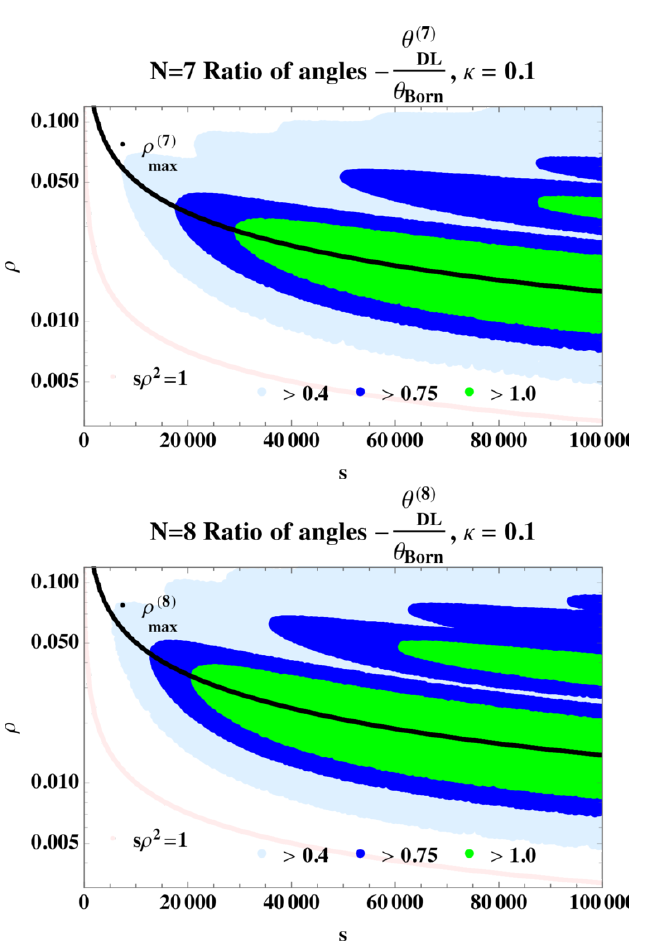
Figure 14 . Regions in impact parameter and energy space where the DL resummation e(cid:11)ects are large ( N =7 up, N =8 bottom). When the ratio (cid:0) (cid:18) it is bigger than 0.4 and 0.75, it corresponds to a large correction but still with a positive angle.